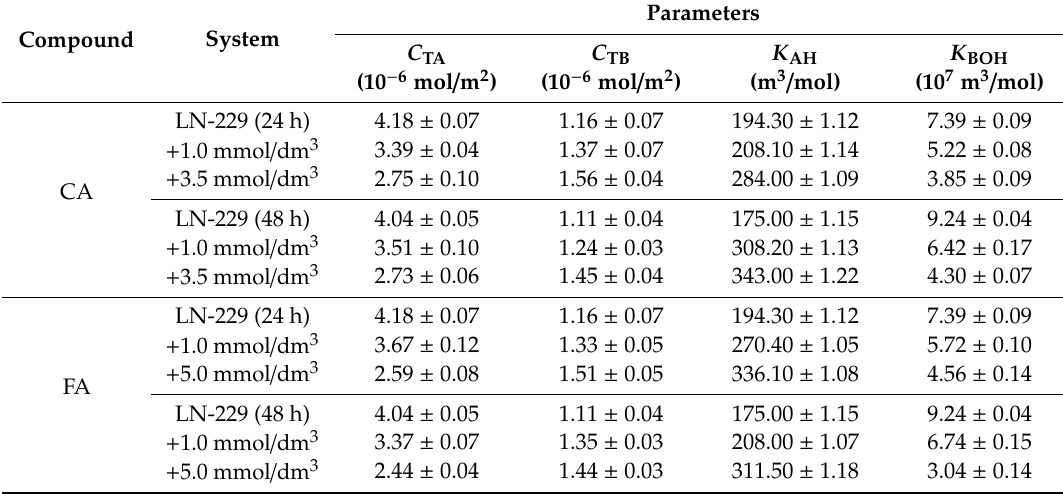
Table 2. E ff ect of cinnamic and ferulic acids on the acidic and basic functional groups concentrations and associations constants with H + and OH − ions of glioblastoma cell lines. Compound